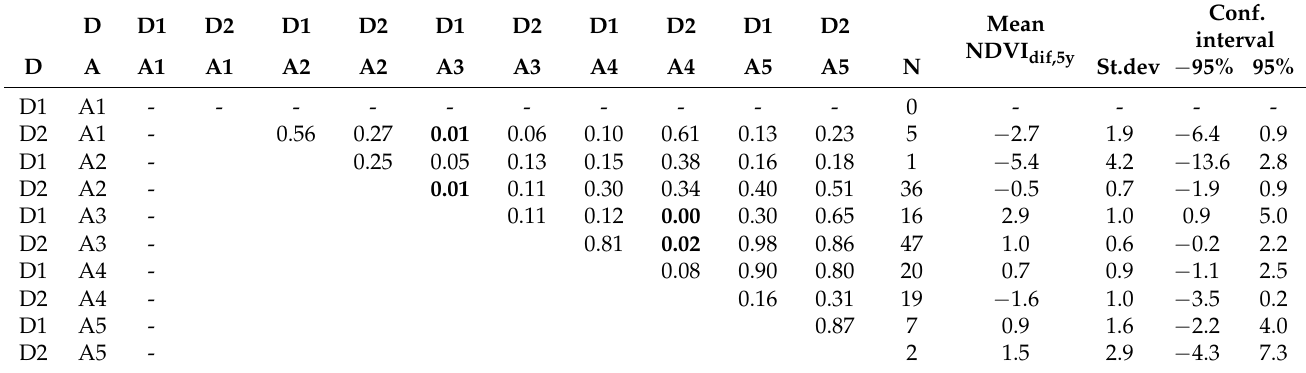
Table 6. Multi-factorial ANOVA with Fisher’s Least Significant Difference (LSD) Post Hoc tests of probabilities of differences of NDVI (NDVI dif,5y ) between the end (2016–2020) and the beginning (2000–2004) of the studied period between groups of altitudinal zones (A) and density classes (D). The significant differences between combinations of A and D with p < 0.05 are in bold. The positive mean NDVI dif,5y values indicate the increase of NDVI in 2016–2020 compared to 2000–2004 and vice